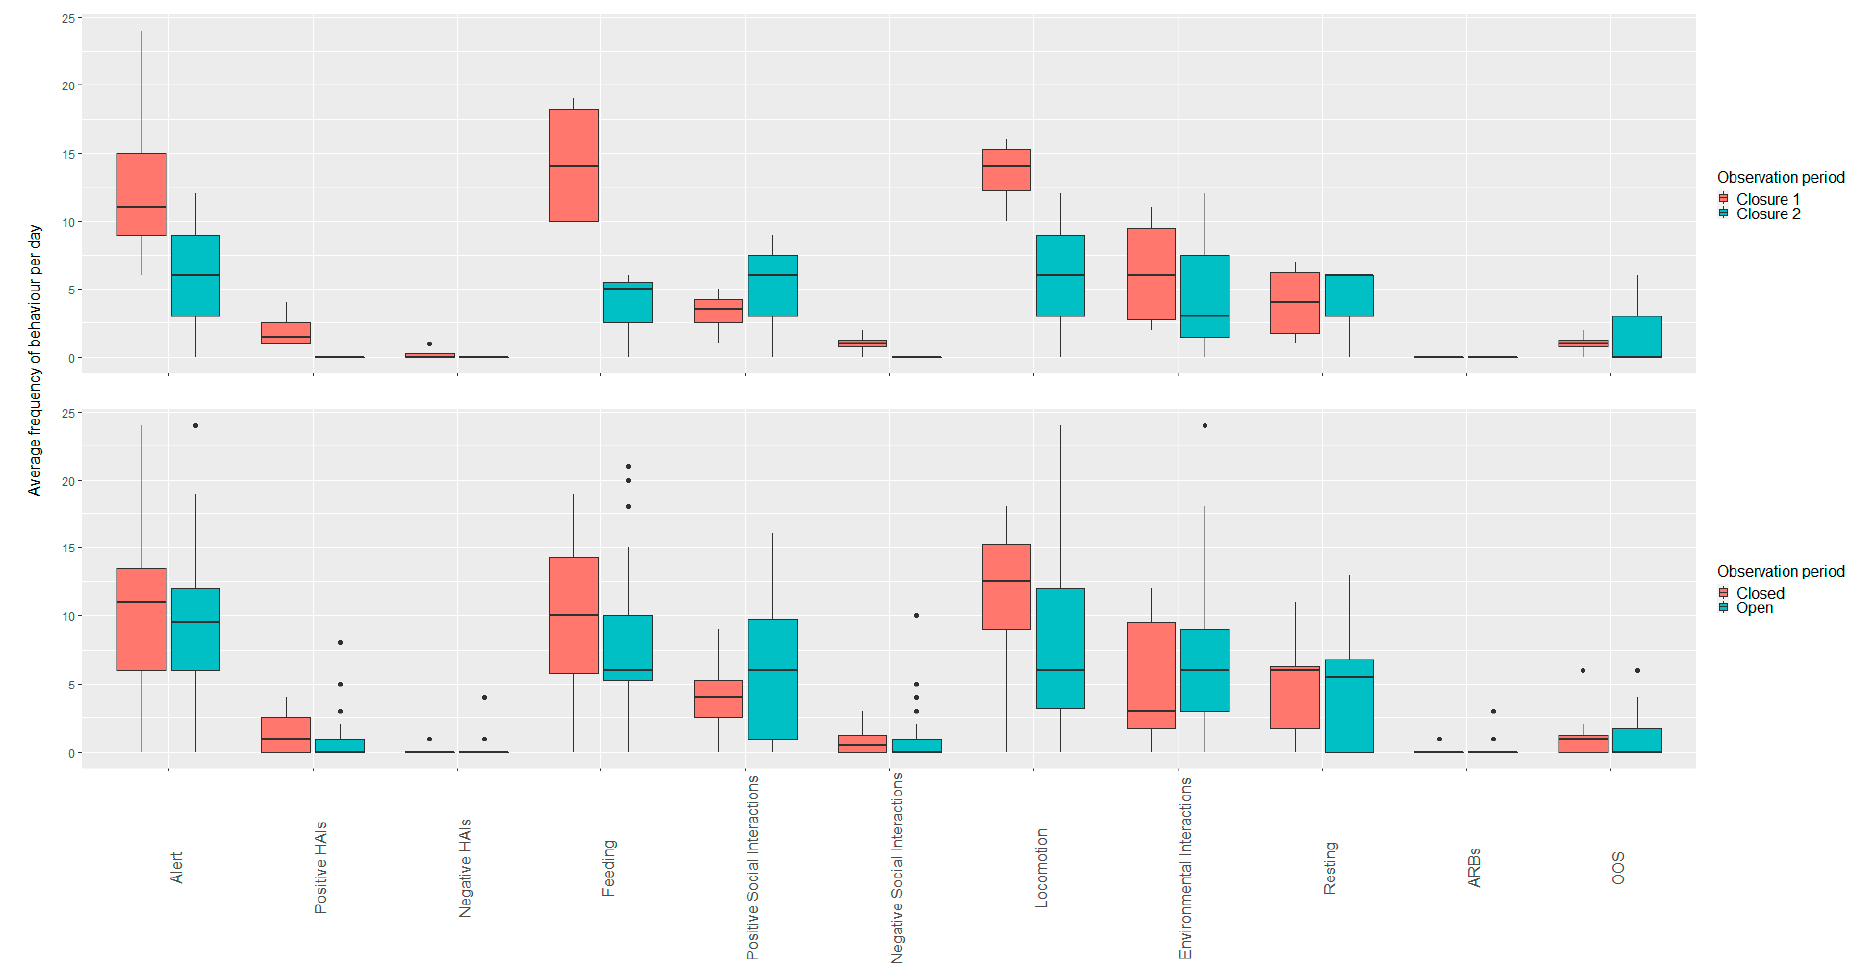
Figure 8. An overview of activity throughout the closure and reopening periods for meerkats housed at Knowsley Safari. Dots represent outliers.